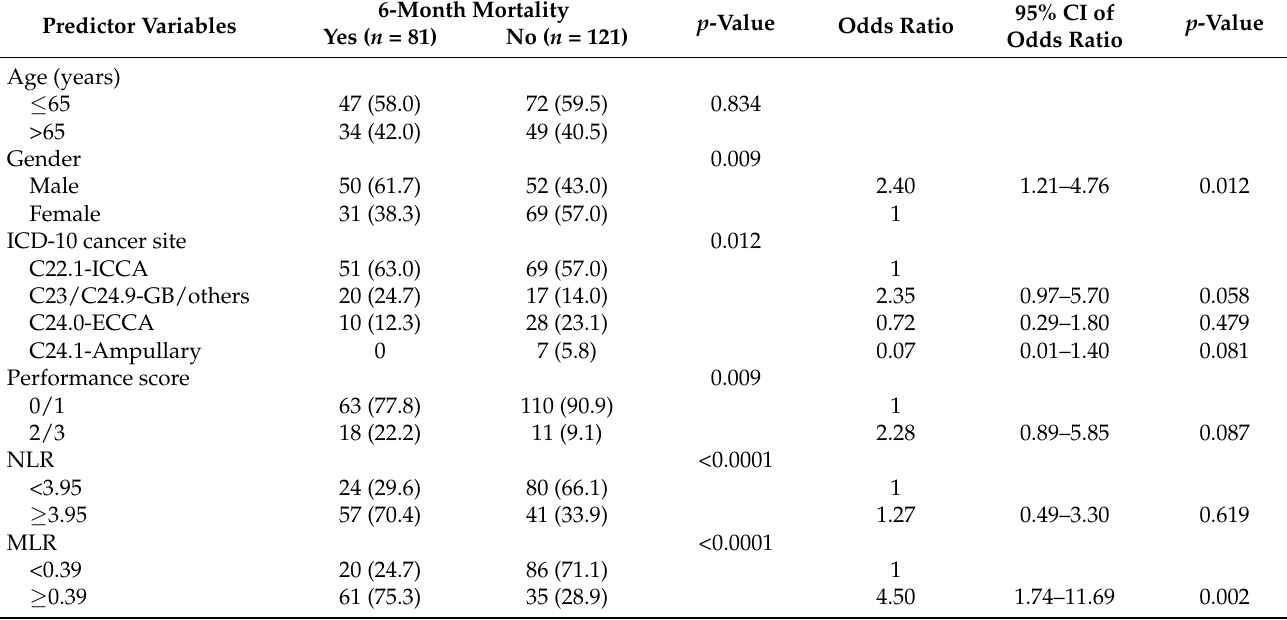
Table 2. Univariate and multivariate analyses ** of patients treated with G-based